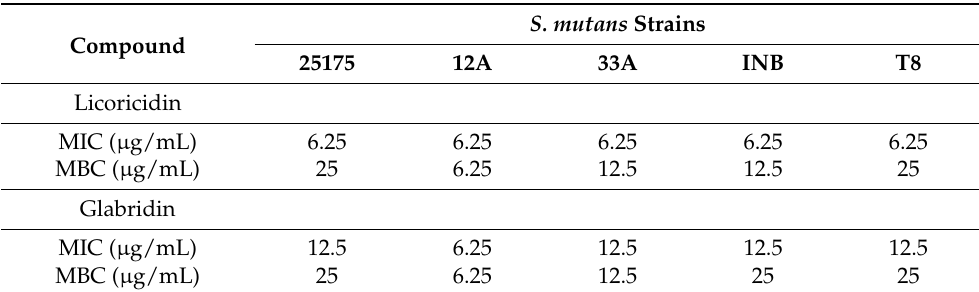
Figure 1. Chemical structures of licoricidin and glabridin. Table 1. Minimum inhibitory concentrations (MICs) and minimum bactericidal concentrations (MBCs) of licoricidin and glabridin against five strains of Streptococcus mutans. Assays were done in triplicate and a representative set of data is presented.